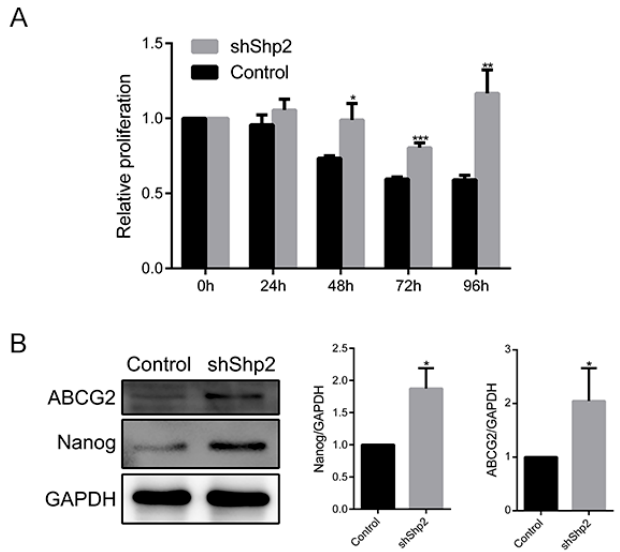
Figure 4. Knockdown of Shp2 reduced sensitivity of Eca109 cells to cisplatin treatment. ( A ) Proliferation of Eca109 shShp2 and control cells treated with cisplatin (10 μ g/mL); ( B ) Expression of ABCG2 and Nanog in Eca109 shShp2 and control cells. (* p < 0.05, ** p < 0.01, *** p < 0.001).